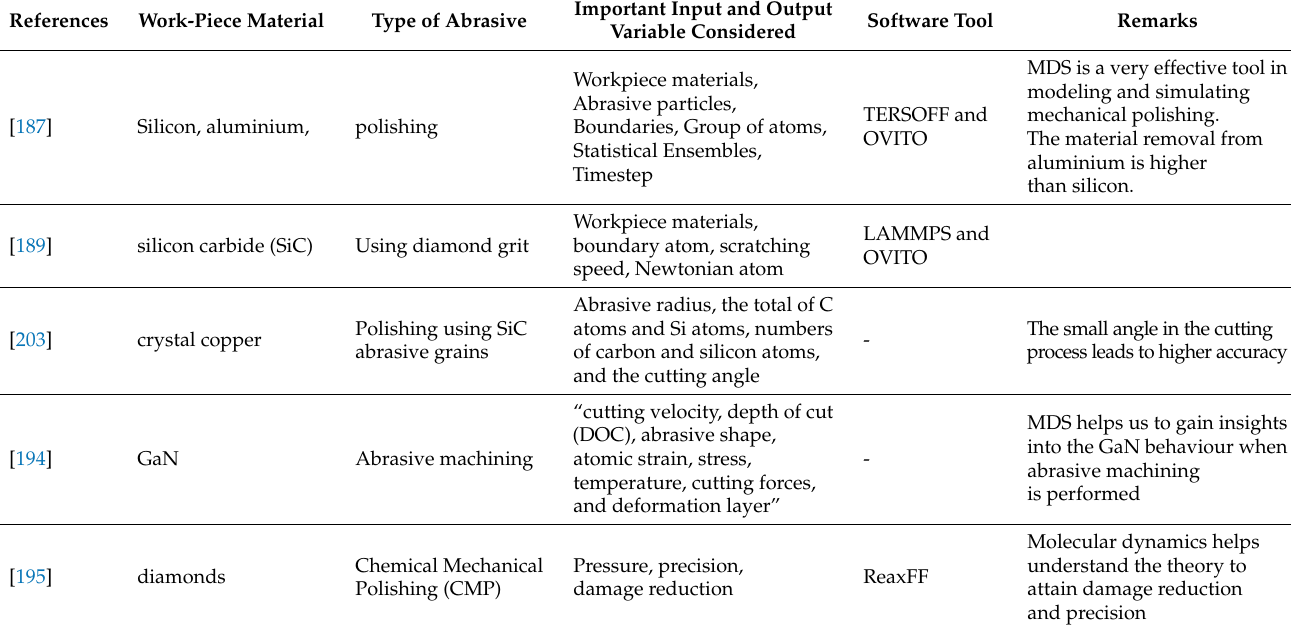
Table 9. Summary table of MDS-based modeling and simulation of the loose abrasive-based